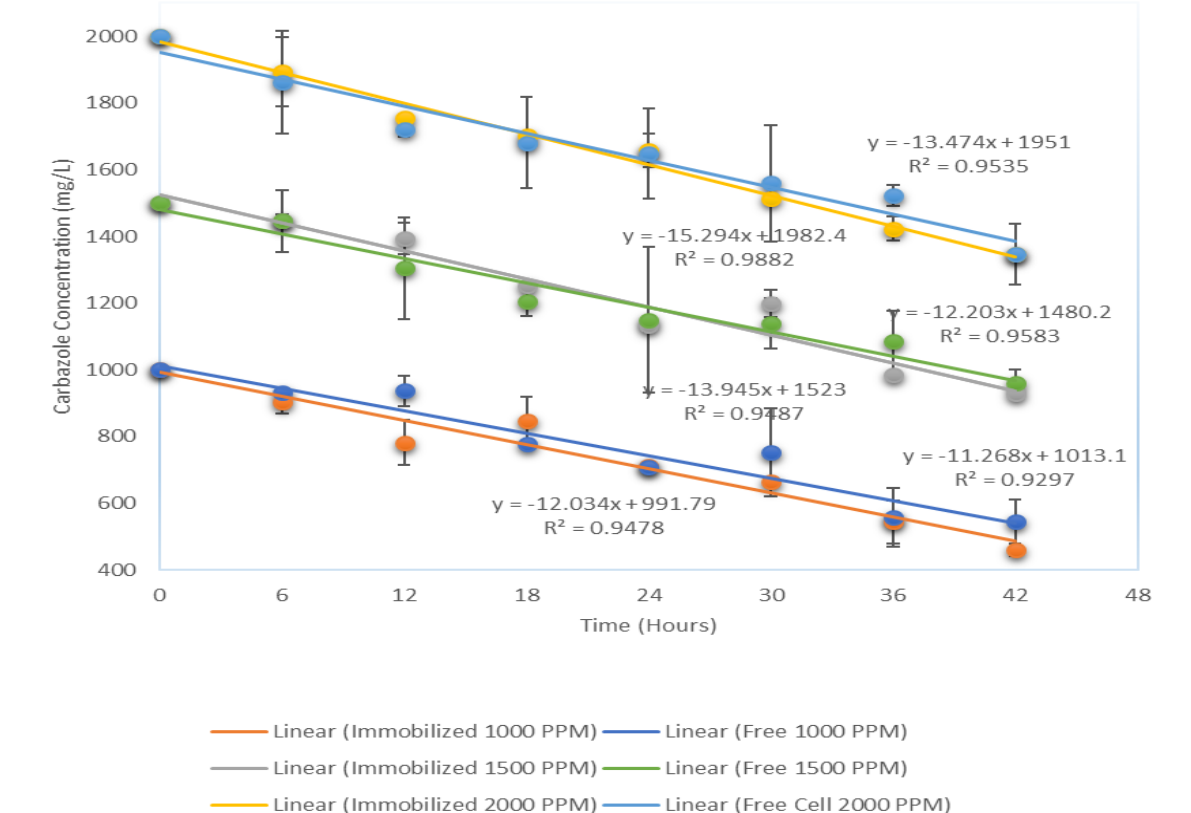
Figure 1. Degradation rate Monod zero order trend line at 1000, 1500 and 2000 ppm in flask